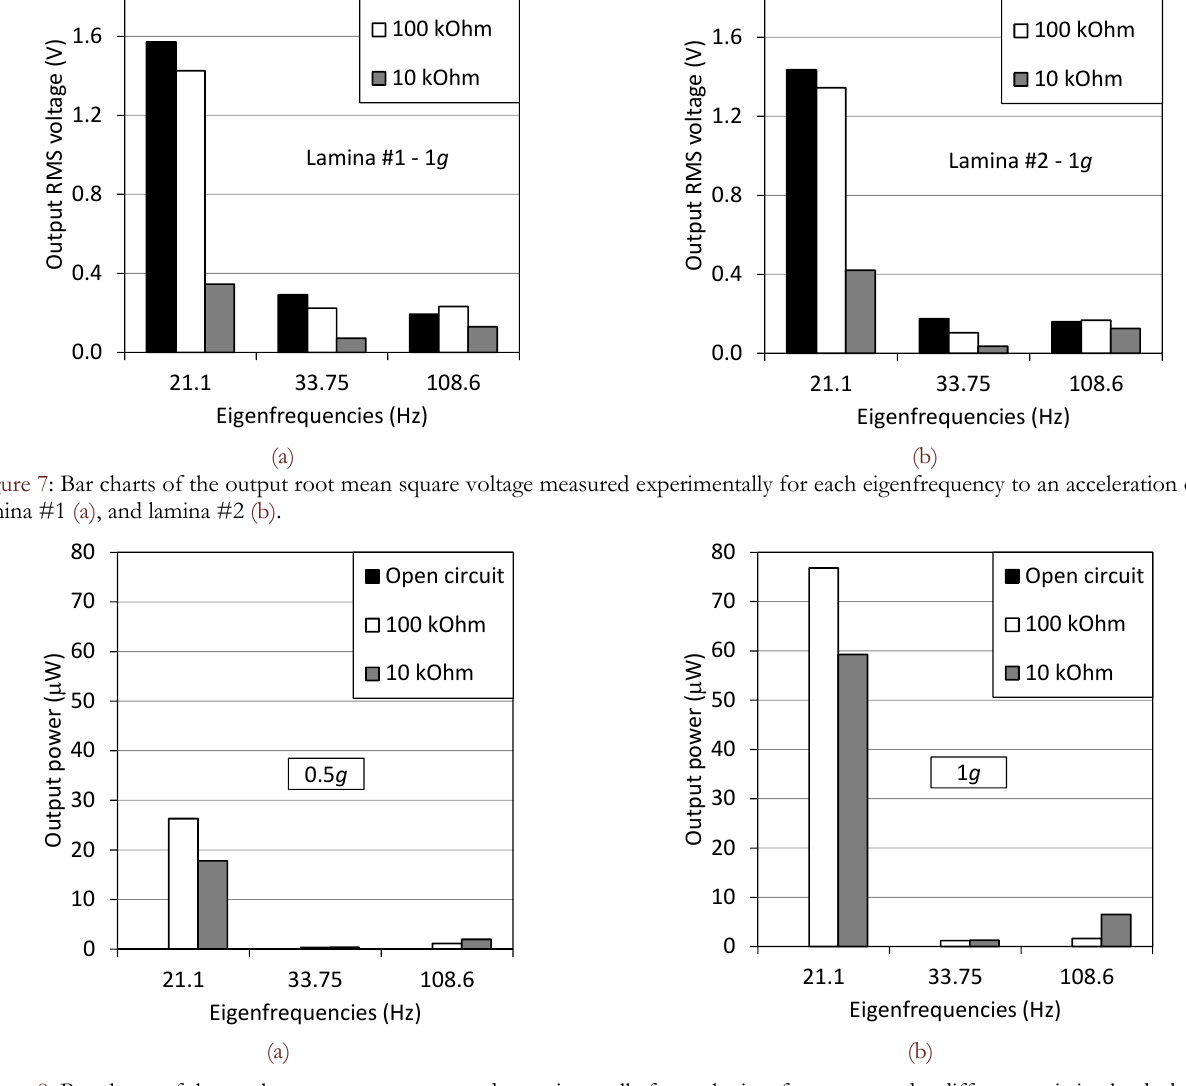
Figure 8: Bar charts of the total output power measured experimentally for each eigenfrequency under different resistive loads, both at 0.5g (a) and 1g